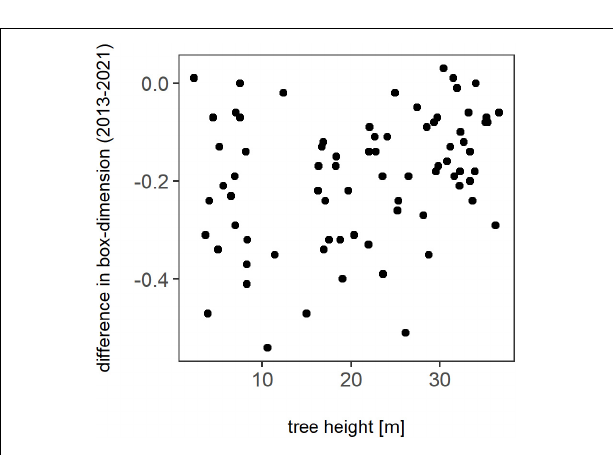
FIGURE 2 | Difference in box-dimension between winter 2013 and winter 2021 for all trees in relation to their height in meter.